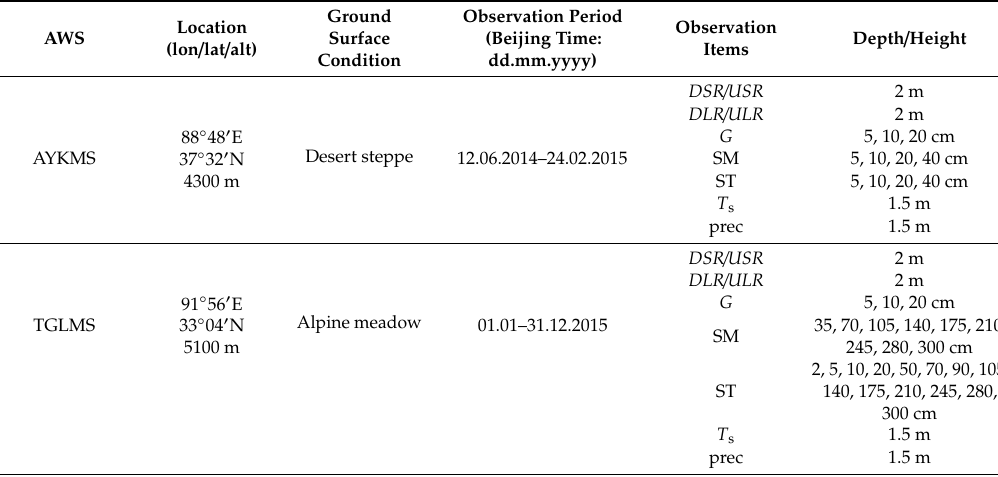
Table 1. Observational instruments and observation